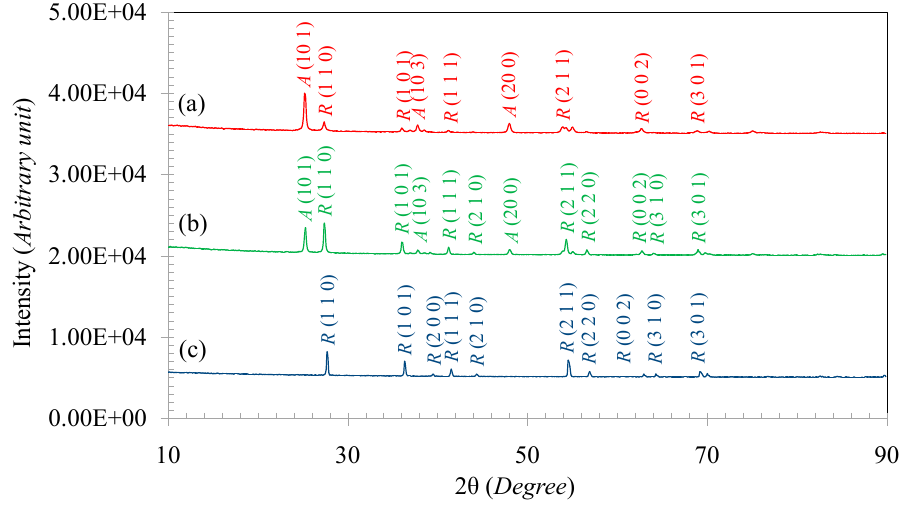
Figure 3. XRD pattern of the TiO particles ( a ) in as-received condition; ( b ) Heat treated 2 at 750 °C for 3 h and ( c ) heat treated at 1000 °C for 1 h in Ar atmosphere. Here, “ A ” and “ R ” represent anatase and rutile, respectively.